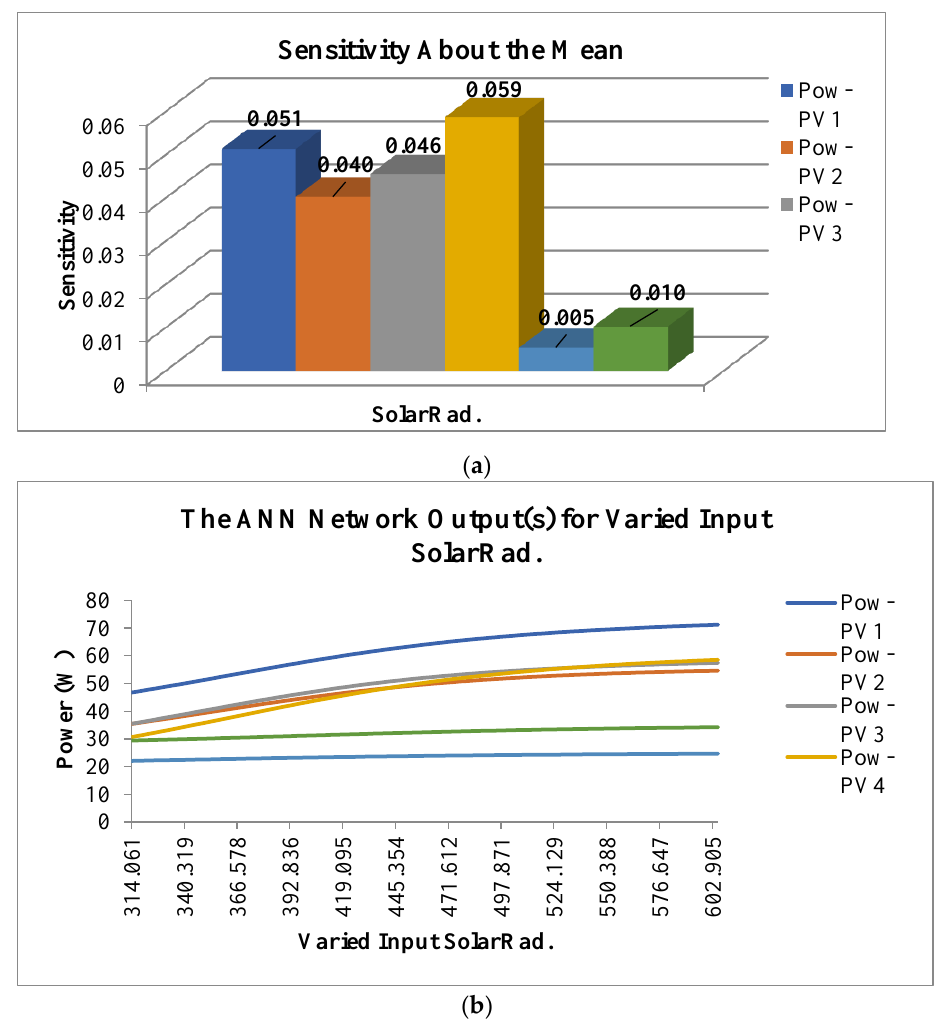
Figure 10. The sensitivity analysis of the input and output variables. ( a ) the SA of the proposed ANN model; ( b ) effects of varied input solar radiation on power production. To compare the results accurately, all experiments must be subjected to the same climatic conditions and other factors used in the experiment. However, this does not prevent us from finding a common factor for comparison, for example, the hot climate or the same type of solar panels, and other factors. Table 7 compares the proposed systems with some of the systems known in the literature survey. The power reduction is increased when the average dust accumulation is high. The dust concentration affected the cell panels more, which required weekly cleaning. Table 7. Comparison results with other studies.